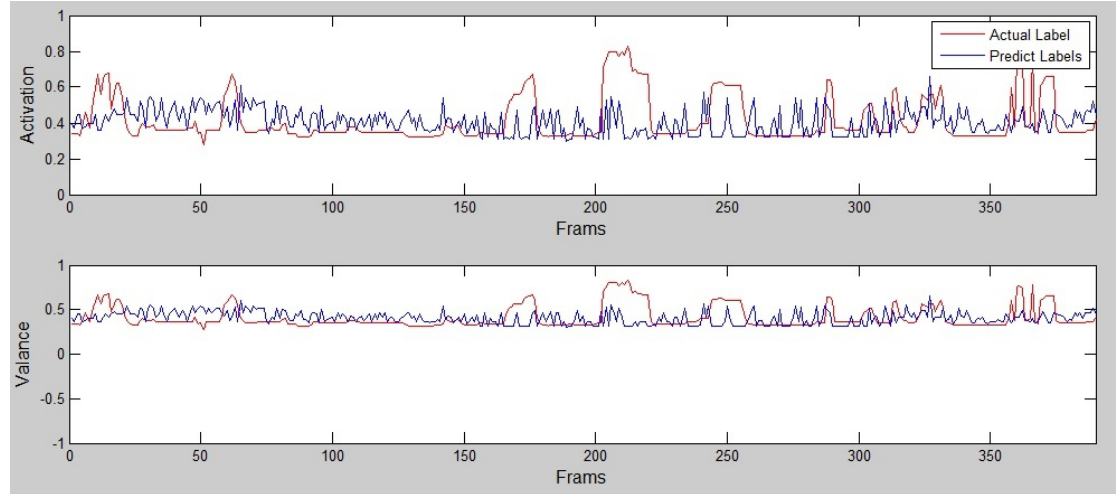
Figure 8. Example of predicted and true valence and activation